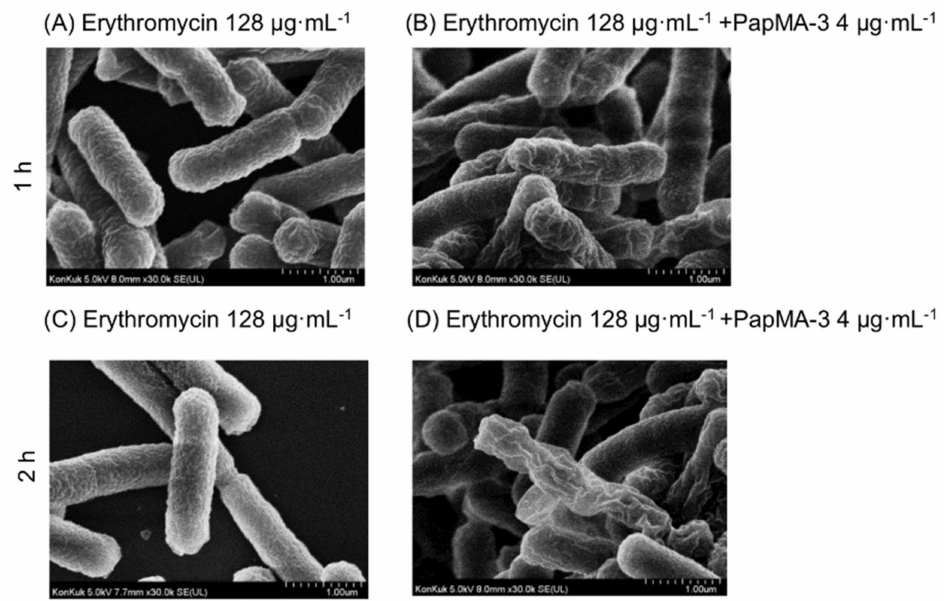
Figure 8. FE-SEM images of CRAB C1 treated with erythromycin and PapMA-3. ( A ) after incubation for 1 h with erythromcyin (128 µ g · mL − 1 ; synergistic concentration) and ( B ) with erythromycin (128 µ g · mL − 1 ) + PapMA-3 (4 µ g · mL − 1 ). ( C ) After incubation for 2 h with erythromcyin (128 µ g · mL − 1 ; synergistic concentration) and ( D ) with